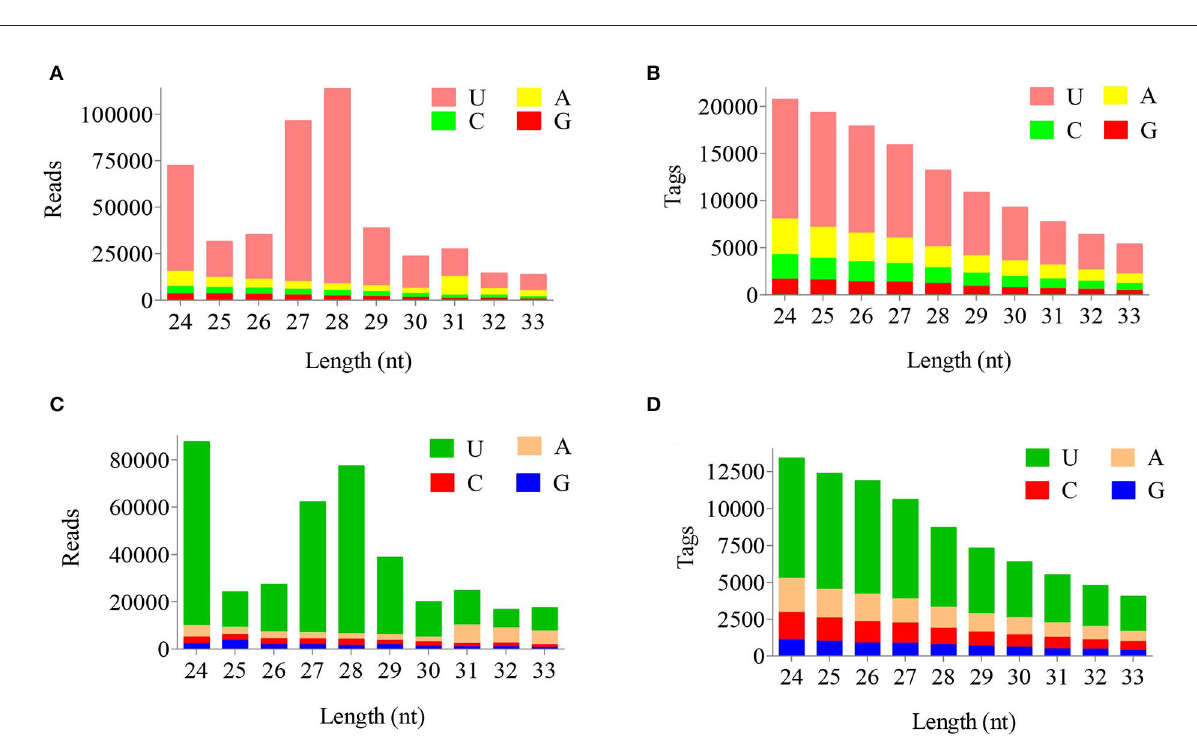
FIGURE1 Length-wise distribution of piRNAs in two groups. Length distribution of piRNA reads (A) and the tags (B) in FP. Length distribution of piRNA reads (C) and the tags (D) in LP.